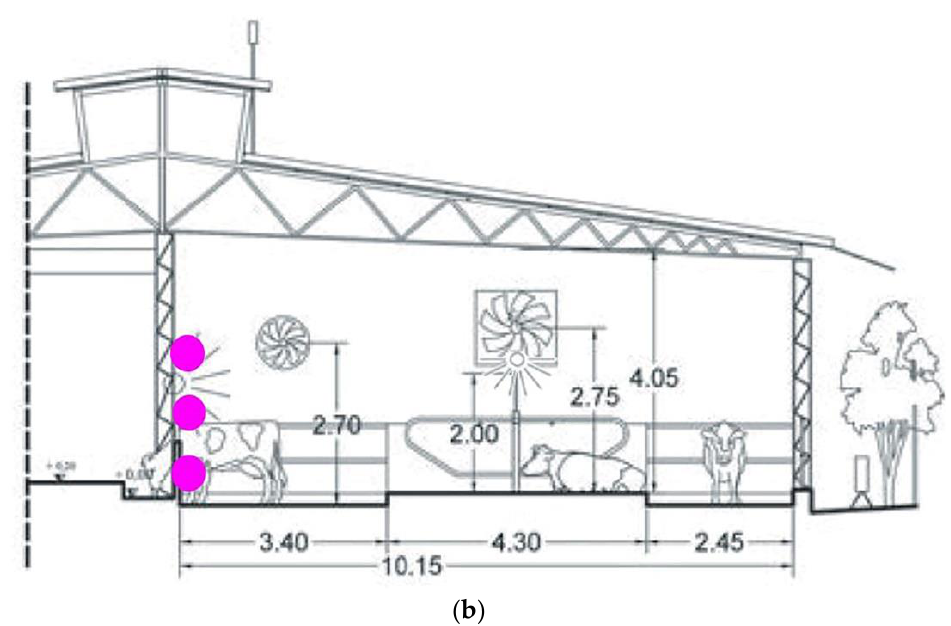
Figure 2. Position of sampling points in the barn. In the plan view of the barn, ( a ) the localization of the sampling pole was located in the central area of the barn. The section of the barn ( b ) shows the vertical distribution of the sampling points in the sample pole at different heights from the floor.